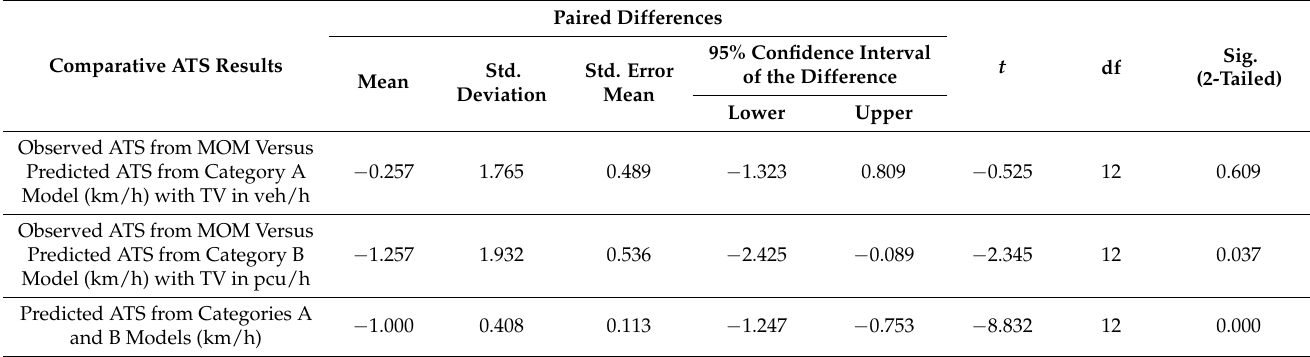
Table A3. Results of paired t -test for model of cross-sectional case of [M0, NL2, SF1].